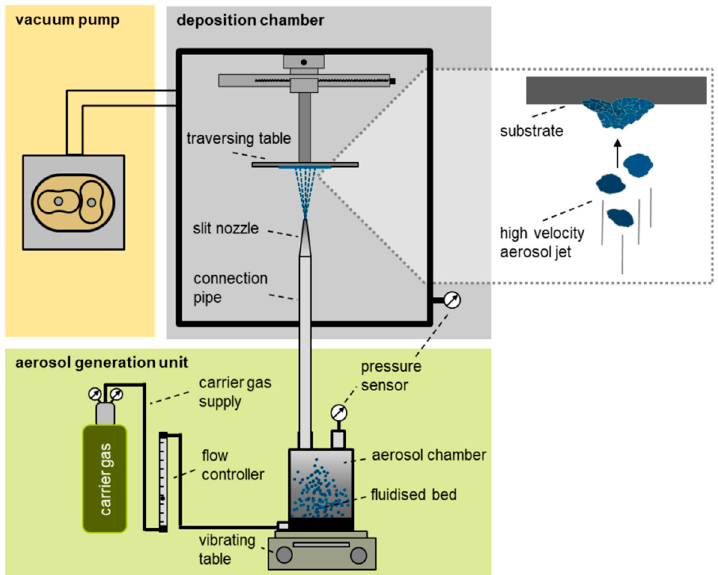
Figure 1. Scheme of aerosol deposition system at the Department of Functional Materials, University of Bayreuth, modified after Panzer et al. [18]. The inset shows impacting particles in the aerosol jet and already deposited particle fragments on the substrate.